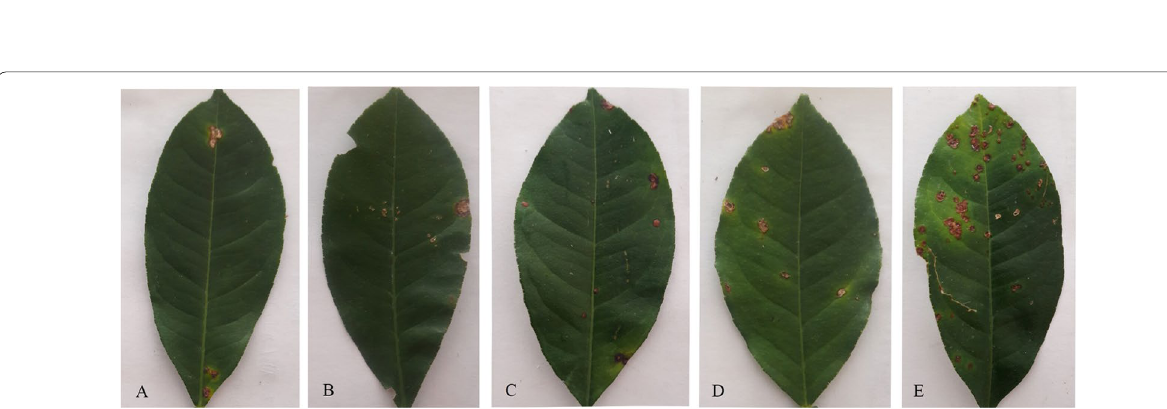
Fig. 10 Citrus canker symptom development on the final day of the experiment on Rangpur lime leaves treated with Xanthomonas citri subsp. citri (XCC) and biocontrol agents. A Leaf treated with the cell suspension (CS) of B1 and XCC, B leaf treated with the cell-free supernatant (CFS) of bacterial isolate (B1), C leaf treated with the CS of bacterial isolate (C8), D leaf treated with the CFS of C8, E leaf treated with XCC only